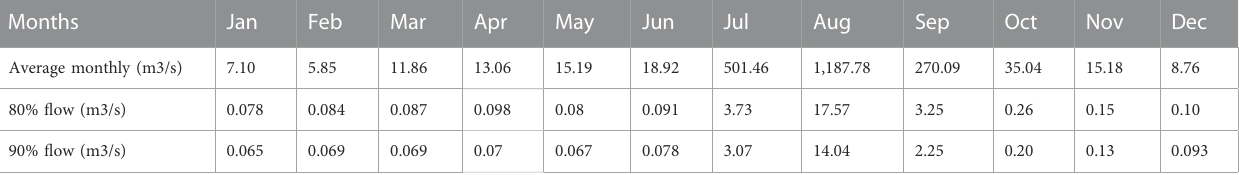
TABLE 7 Average monthly stream fl ow and monthly fl ow duration curve analysis using 80 and 90%